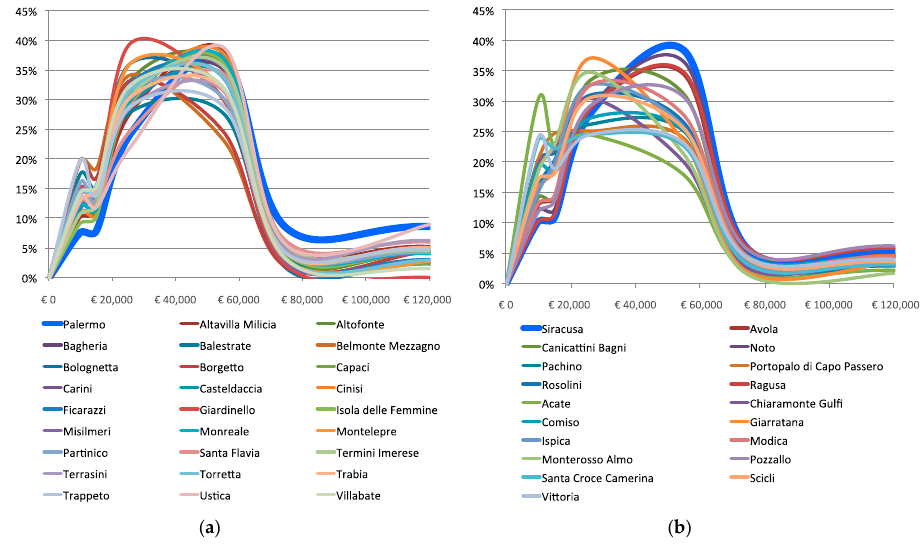
Figure 5. Percentage of the annual income levels ( x -axis) per municipality in the NWS ( a ) and SES ( b ) areas (including capital cities) (our elaboration on ISTAT data).